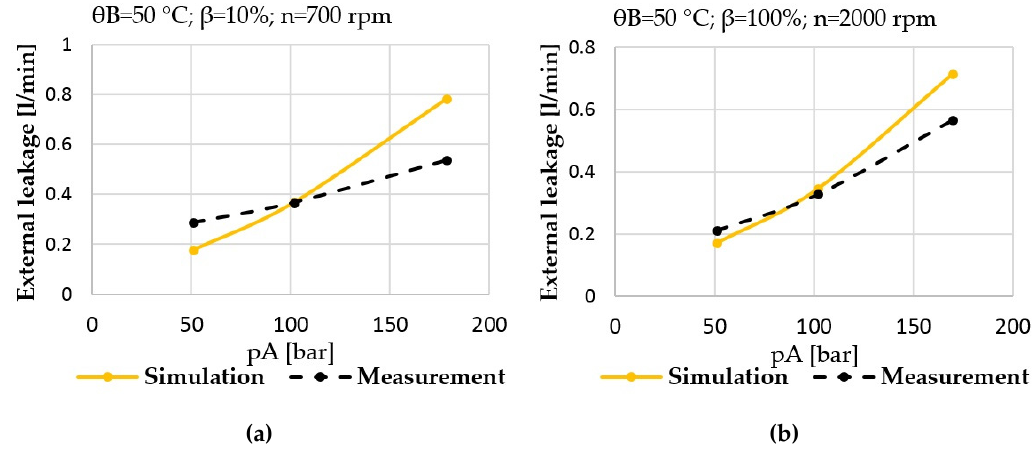
Figure 15. ( a ) Prediction vs. measurement; total external leakage of the pump at low power operating condition; ( b ) prediction vs. measurement; total external leakage of the pump at high power operating condition.